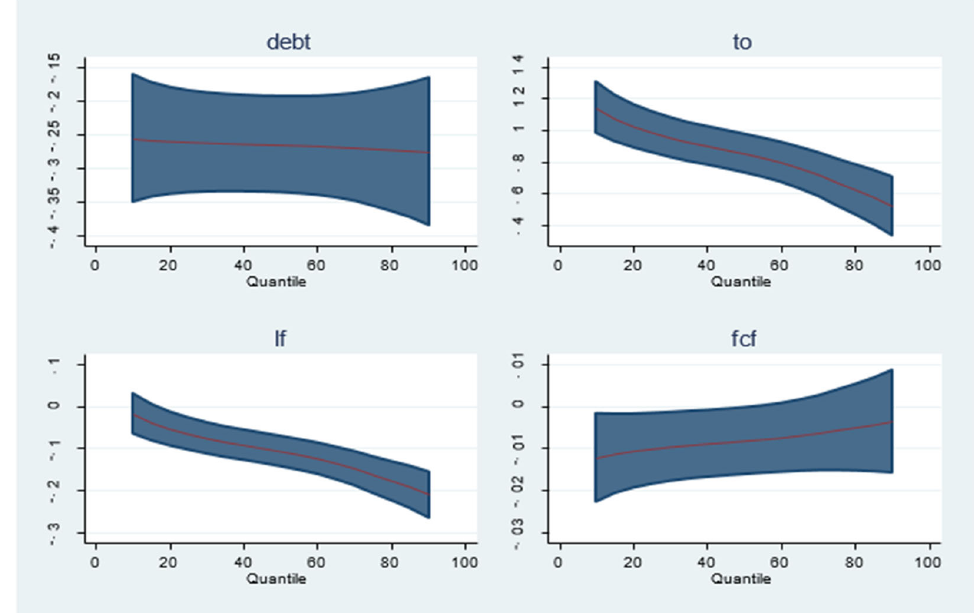
Figure 1. The Impact of public debt on growth under different quantiles.